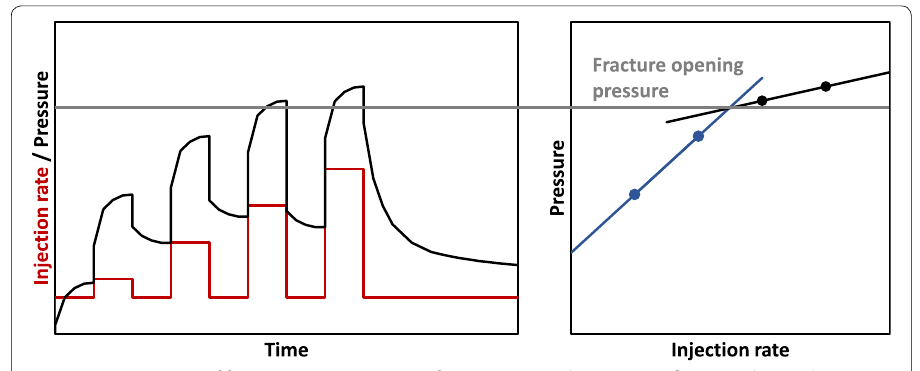
Fig. 5 Determination of fracture opening pressure from progressively increasing flow rate data at the beginning of each long‑term cycle. The blue line indicates a matrix flow regime and the black line indicates a fracture flow regime. The fracture opening pressure marks the transition between